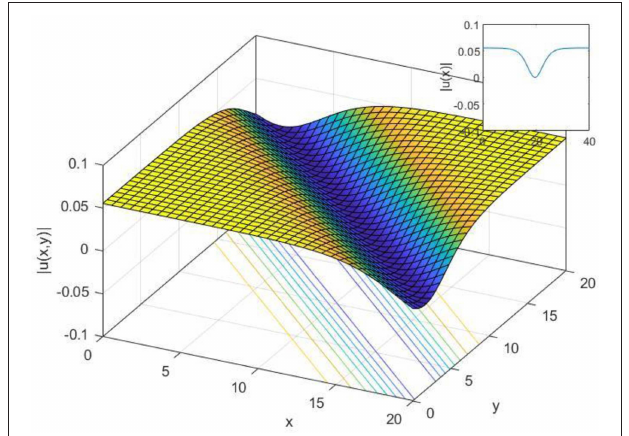
FIGURE 1 | 2-D, 3-D, and contour plot of dark soliton solution Equation (20) when λ for 2-D.